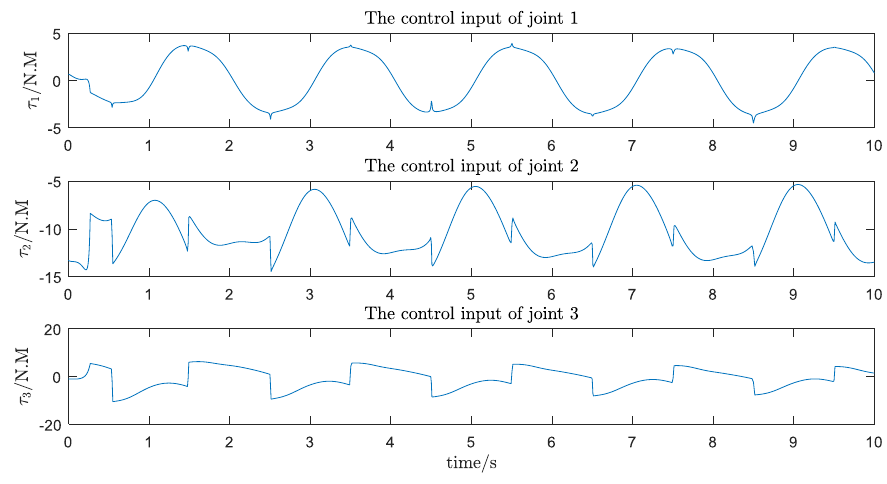
Figure 19. The control input of each joint.